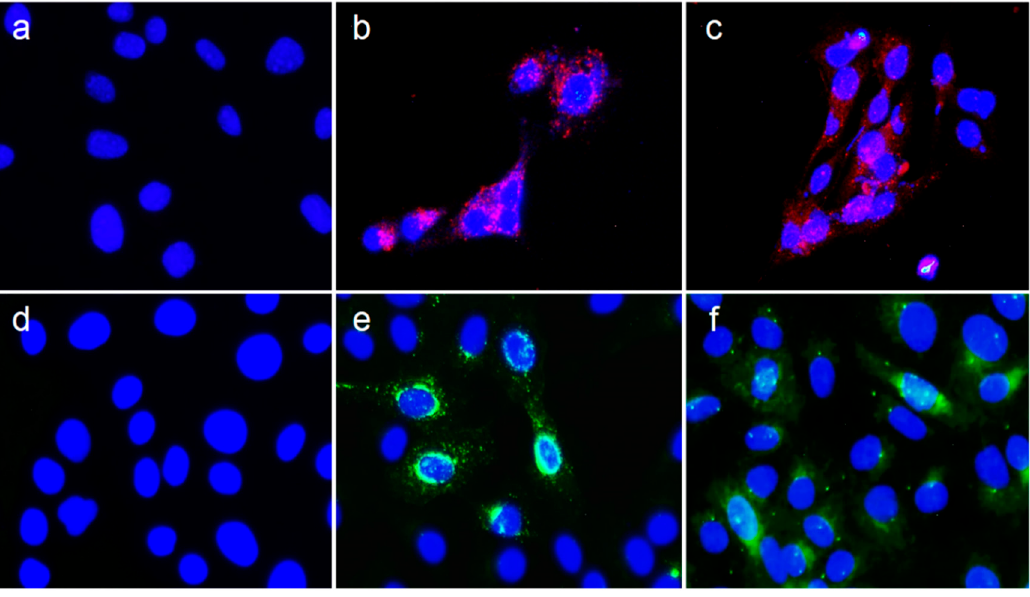
Figure 2. Analysis of BTV-4 NS1 and NS1-Nt protein expression by indirect immunofluorescence assay. Top Row: Detection of recombinant protein in DF-1 cells infected with ( a ) MVA-wt (negative control), ( b ) MVA-NS1 or ( c ) MVA-NS1-Nt at a MOI of 1. Bottom row: Detection of recombinant protein in HEK-293 cells infected with ( d ) ChAdOx1-wt (negative control), ChAdOx1-NS1 ( e ) or ( f